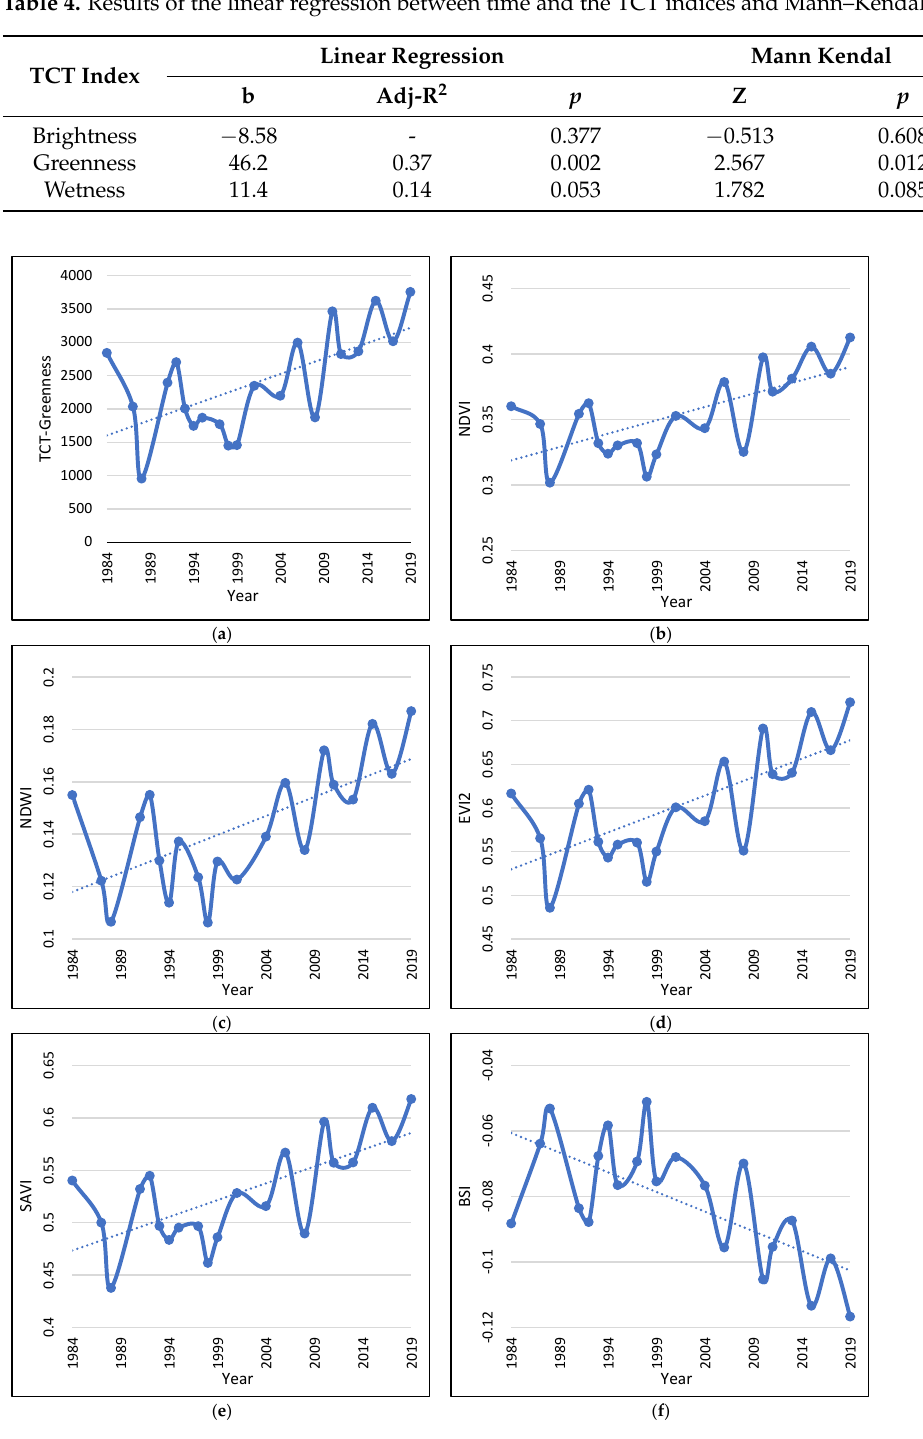
Figure 3. Vegetation Indices dynamics and trend during the study period ( a – f ). The graphs are built based on the 1000 randomly located points, corresponding to 1000 pixels.